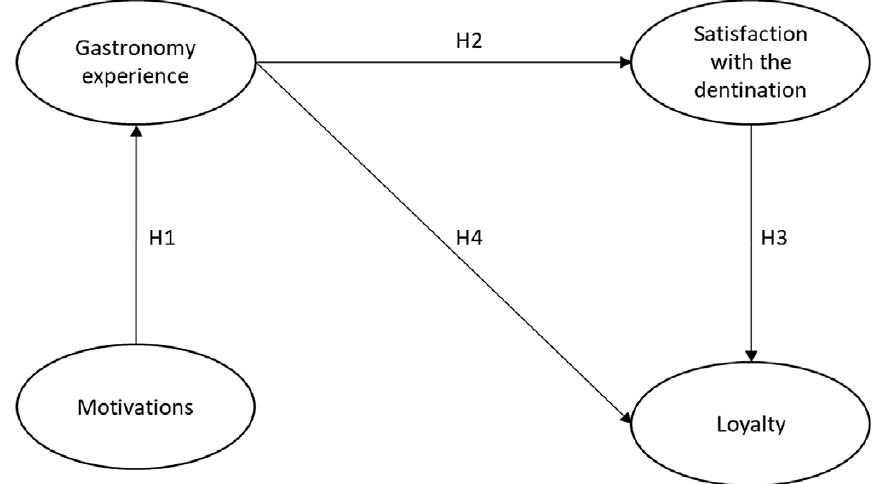
Figure 2. Proposed Theoretical Model of Gastronomic Experience.